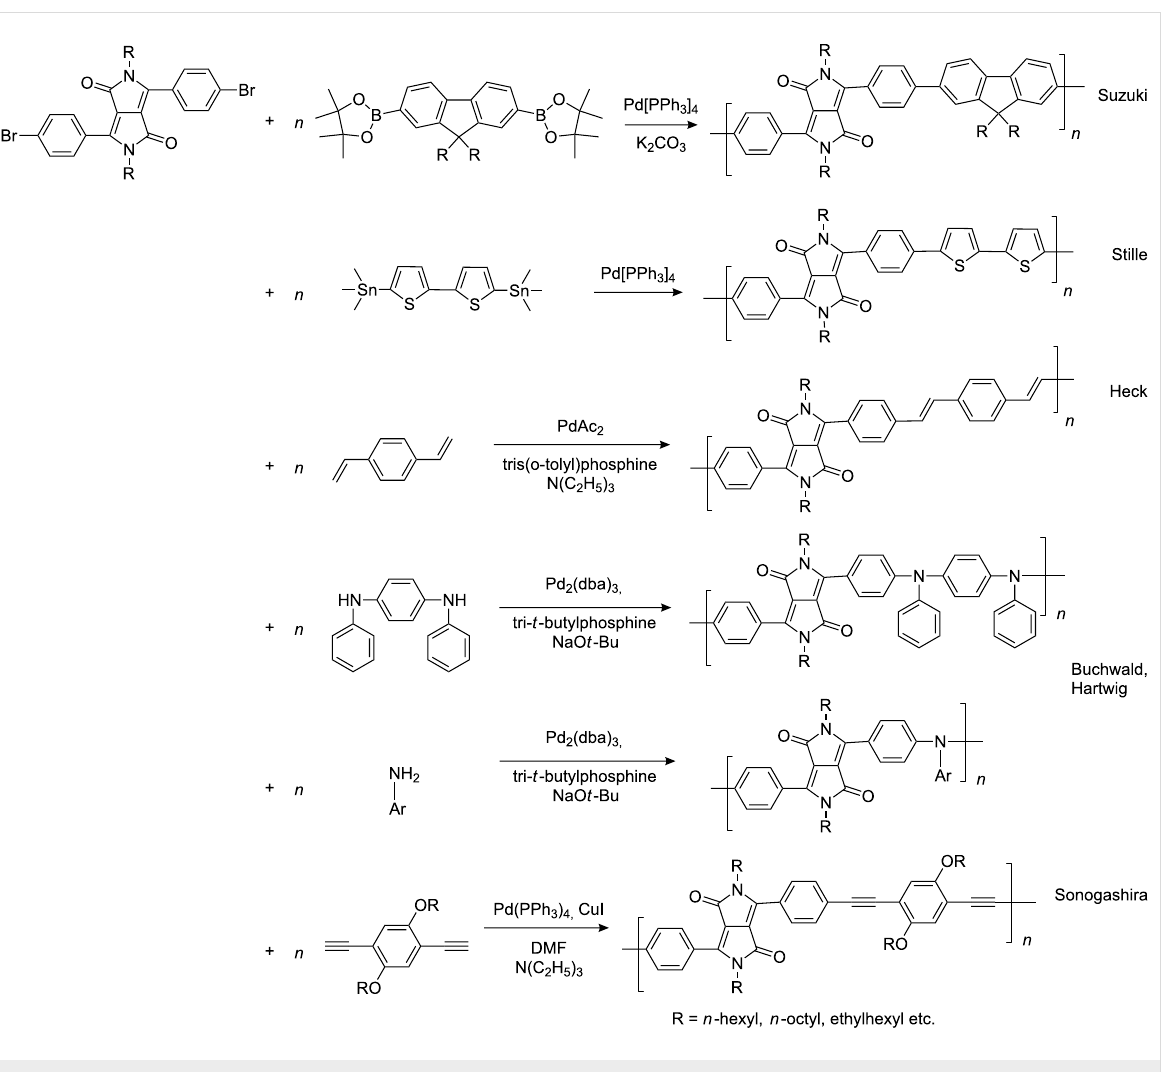
Scheme 2: Pd-catalyzed coupling reactions for preparation of DPP-containing polymers.